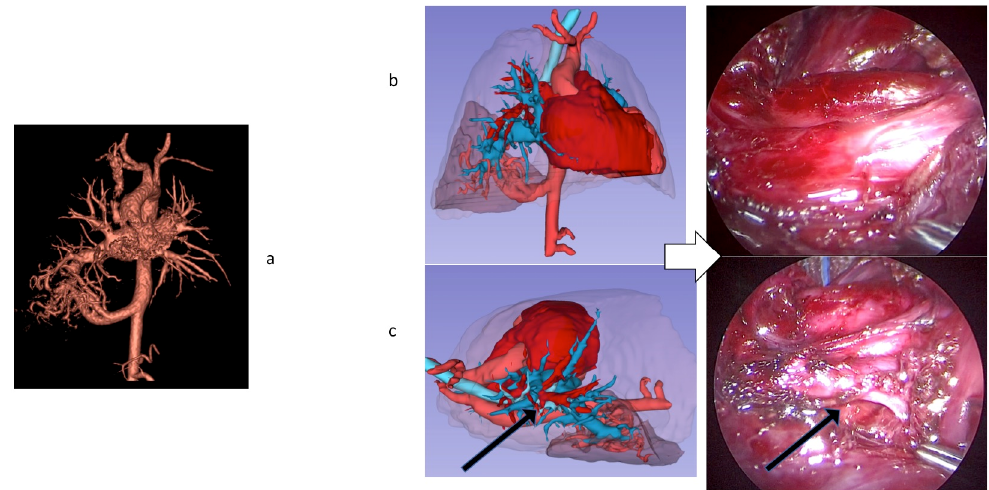
Figure 2. Malformation in patient 1. Panel (a) , anatomical details of sub-subsegmental pulmonary artery branches; Panel (b), the augmented reality model allows the surgeon and all the team to preoperatively interact in the operative room. Panel (c), intraoperative findings: isolation of the inferior right pulmonary vein closed in its dilated portion, 3 venous vessels efferent from the lesion.